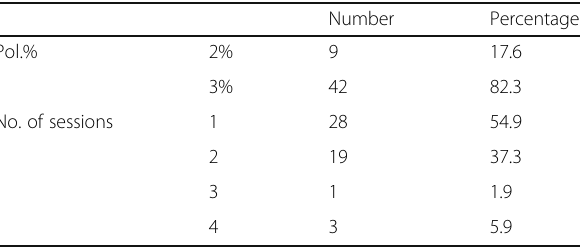
Table 3 Polidocanol concentration injected and the number of